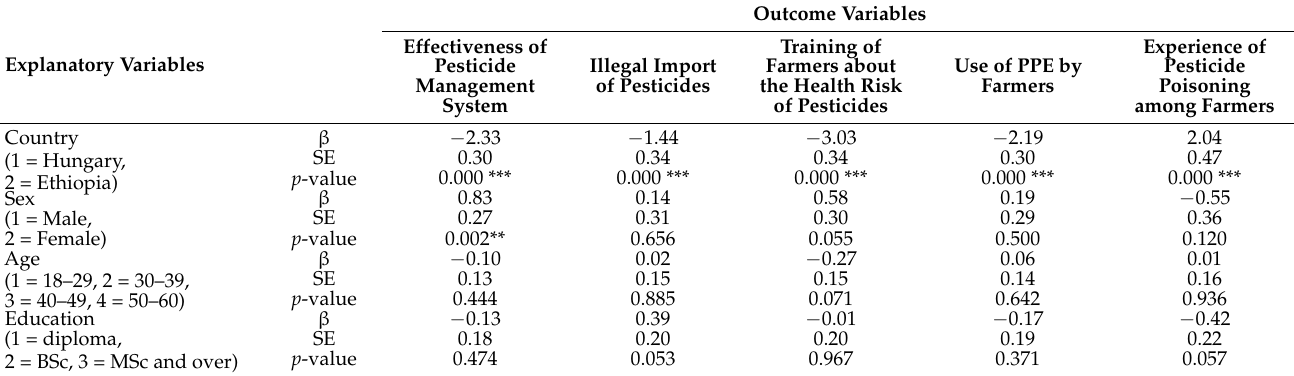
Table 7. Factors determining practice of using pesticides among officers in Hungary and